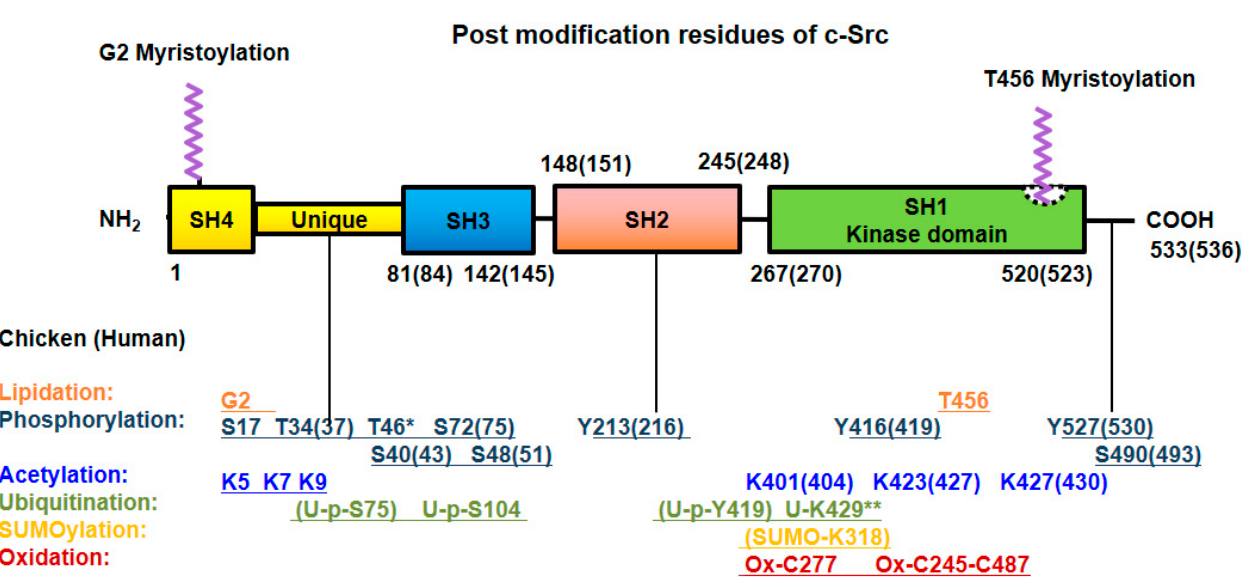
Figure 2. Post-translational modifications of Src. Src undergoes post-translational modification with lipidation, phosphorylation at Ser/Thr and Tyr residues, acetylation, ubiquitylation, SUMOylation and oxidation for its own particular purpose. The numbers of modified amino acid residues in the domains of chicken (human) proteins are denoted. * Referred to chicken only, ** referred to MDCK cell line ( Canis familiaris , dog) [40] . Table 1. Post-translational modifications of Src.